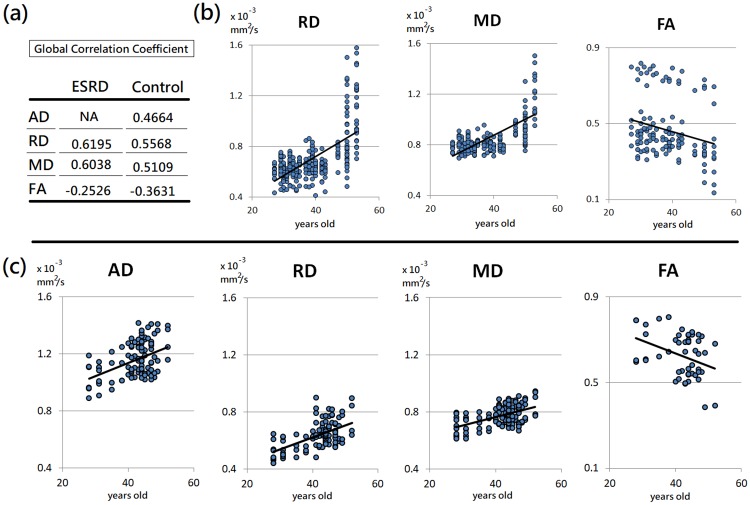
Correlations of DTI indices and age in ESRD patients and healthy controls.In whole-brain significant clusters, the correlation analysis showed significant correlations of DTI indices and age (a) in both ESRD patients (b) and healthy controls (c).